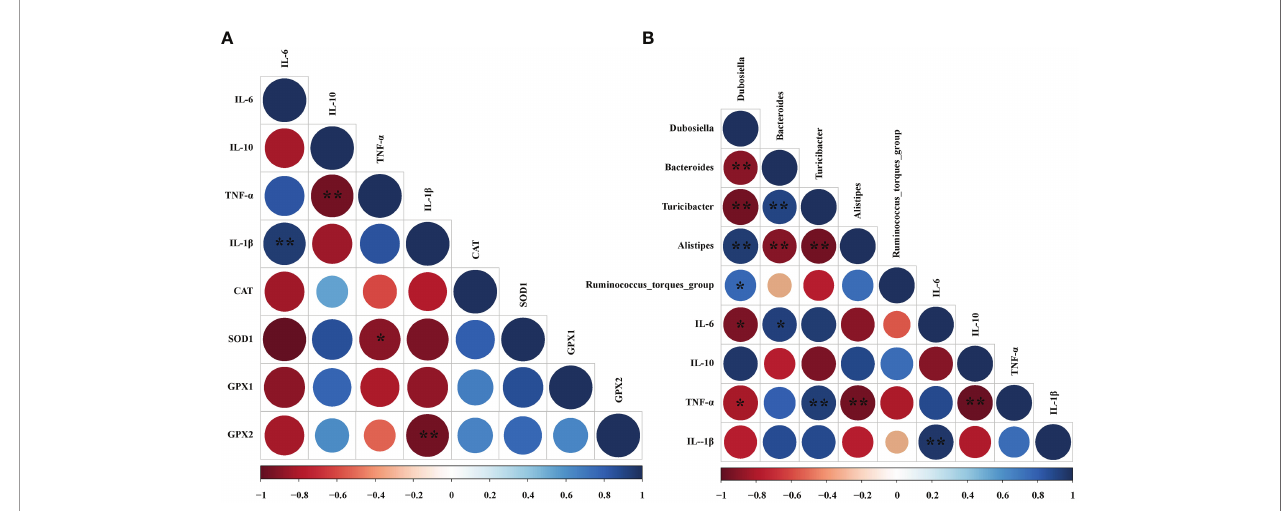
FIGURE 8 | Correlation analysis between oxidative indexes, microorganisms, and in fl ammatory cell cytokines in DSS-induced colitis mice. (A) Correlation analyses between the oxidative indexes and colon mRNA expression of in fl ammatory cytokines. (B) Correlation analyses between the colonic microbiota and colon mRNA expression of in fl ammatory cytokines. The color of the circles demonstrated the level of the correlation index, and the size of the circles represents the strength of correlation (large size = stronger correlation). The * P < 0.05 and ** P < 0.01 represents correlation with each